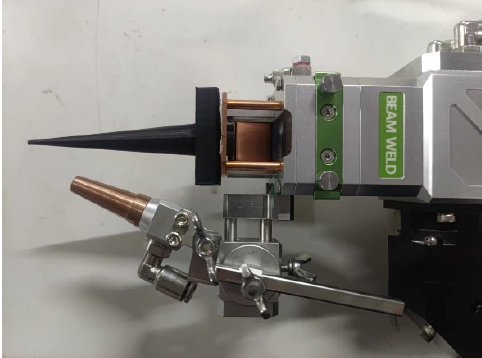
Figure 17. The auxiliary positioning tool.